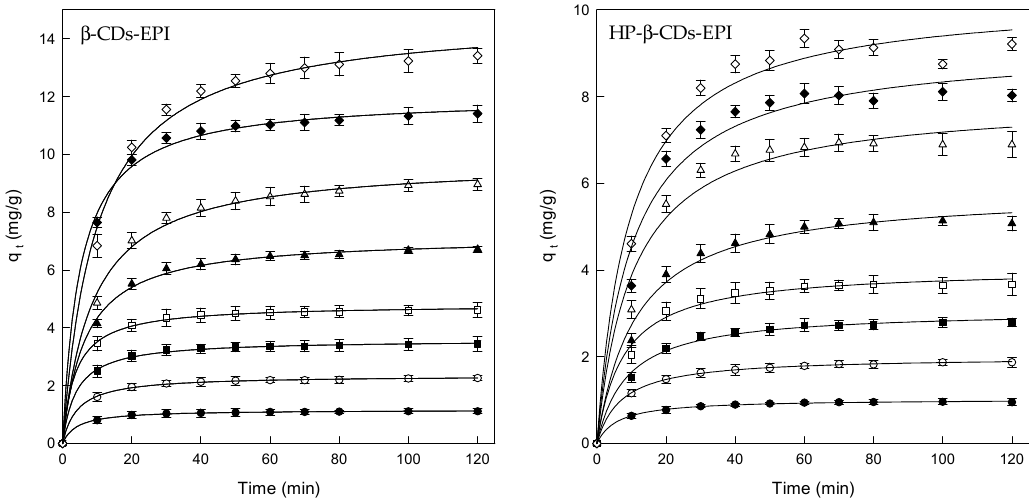
Figure 1. Amount of Direct Red 83:1 adsorbed by β -CDs-EPI and HP- β -CDs-EPI as function of contact time, for different dye concentrations. 25 mg/L ( ● ), 50 mg/L ( ○ ), 75 mg/L ( ■ ), 100 mg/L ( □ ), 150 mg/L ( ▲ ), 200 mg/L ( Δ ), 250 mg/L ( ♦ ) and 300 mg/L ( ⟡ ).